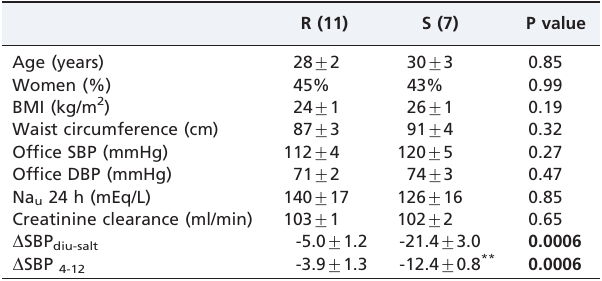
Table 1 - Clinical characteristics of the volunteers included in the study protocol. Data are reported as means ¡ SEM, with the number of volunteers in parentheses.